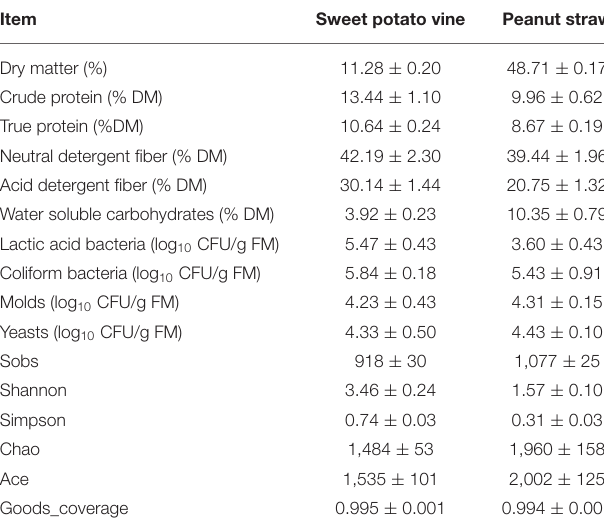
TABLE 1 | Characteristics of raw sweet potato vine and peanut straw.